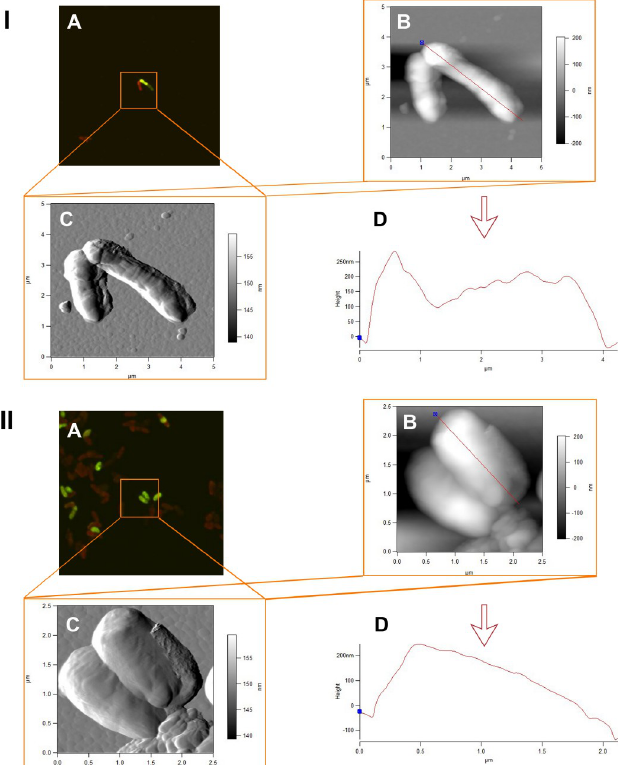
Fig 7. CLSM (A) and AFM (B, C) images and profiles (D) of R . cerastii IEGM 1278. Cells were grown for 4 days in the RS medium supplemented with 0.1% n -hexadecane (I) and 100 mg/L IBP and 0.1% n -hexadecane (II). The scale bars on the CLSM images correspond to 5 μ